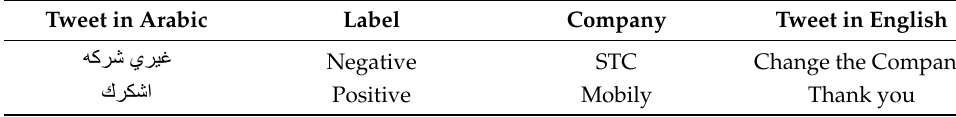
Table 6. Subset of the AraCust corpus after pre-processing.